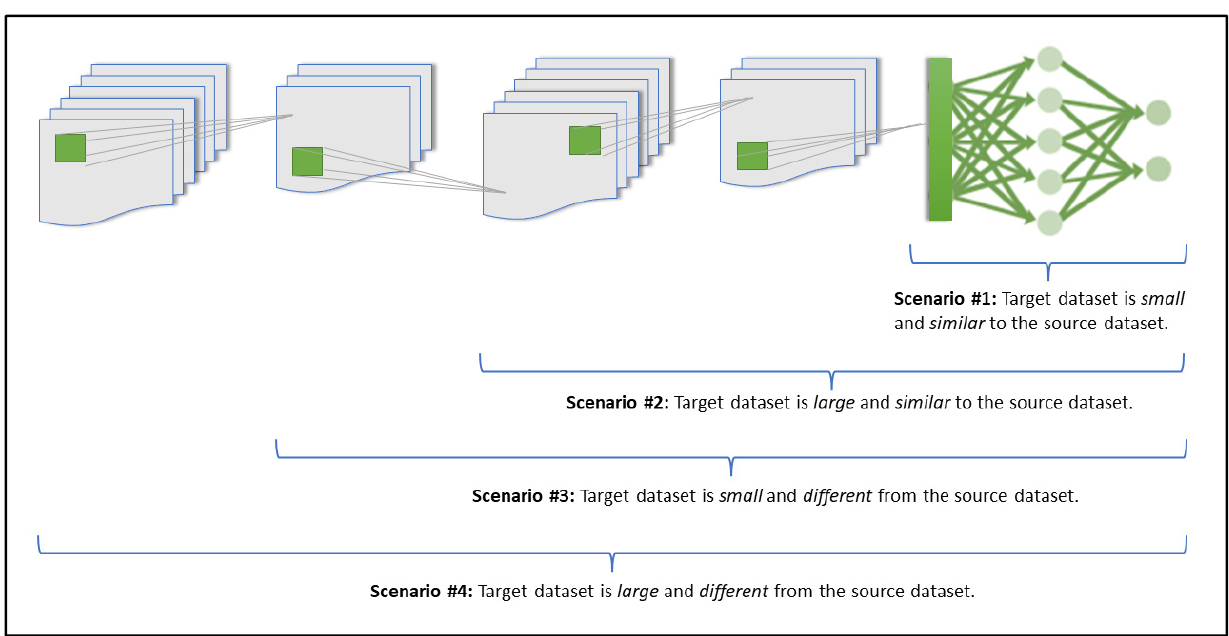
Figure 1. The four transfer learning scenarios and their respective fine-tuning guidelines (inspired by [20]). by